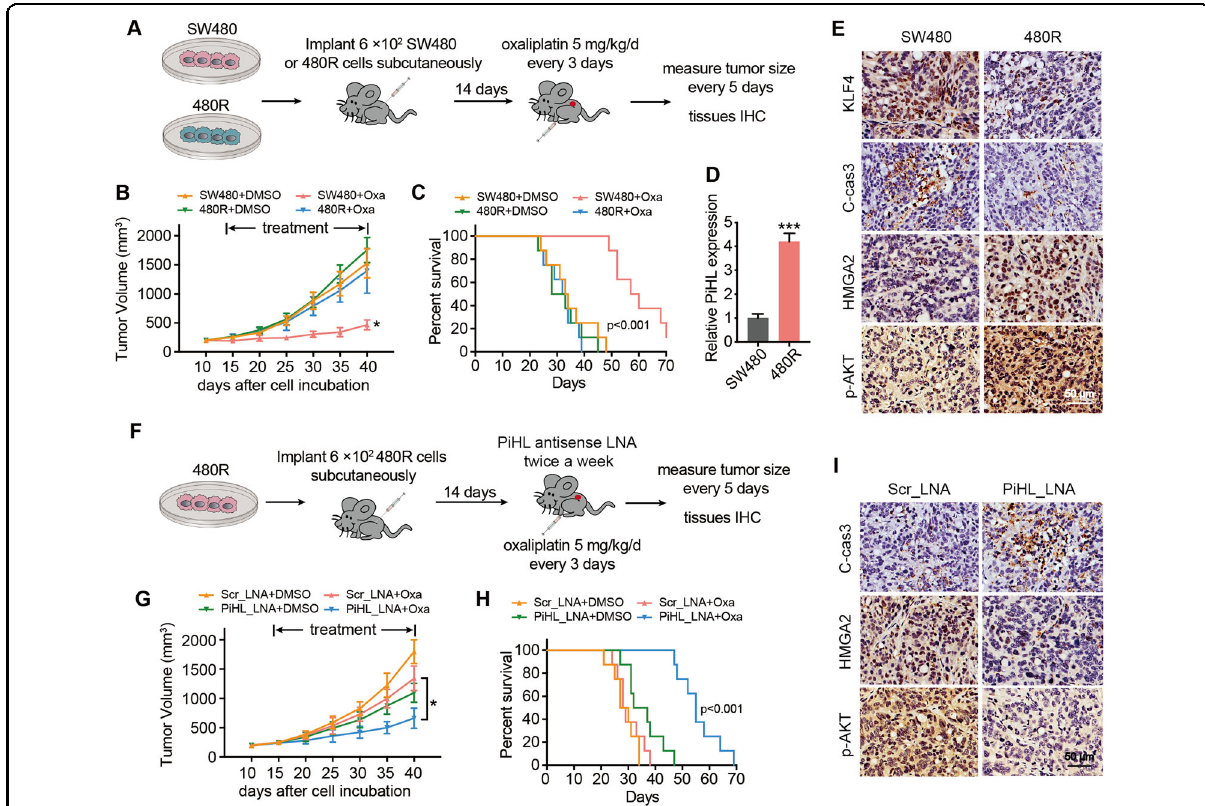
Fig. 6 Knockdown of PiHL restores oxaliplatin sensitivity in Oxa-resistant CRC xenografts. A Nude mice were subcutaneously xenografted with SW480 and 480R CRC cells (6 × 10 2 cells) and treated intraperitoneally with oxaliplatin (5 mg/kg/day per mouse) or DMSO (0.3%) every 5 days. B Relative tumor volumes are presented as mean ± SD, n = 8. C Kaplan – Meier survival curve of nude mice is shown. D PiHL levels in SW480 and 480R xenografts were analyzed by qRT-PCR. E IHC staining of KLF4, cleaved caspase-3, HMGA2, and p-Akt in consecutive tumor sections of mice subcutaneously xenografted with SW480 and 480R CRC cells. Scale bar = 50 μ m. F Nude mice were subcutaneously xenografted with 480R CRC cells (6 × 10 2 cells) transfected with PiHL_LNA or LNA_scramble and treated intraperitoneally with oxaliplatin (5 mg/kg/day per mouse) or DMSO (0.3%) every 5 days. G Relative tumor volumes are presented as mean ± SD, n = 8. H Kaplan – Meier survival curve of nude mice is shown. I IHC staining of cleaved caspase-3, HMGA2, and p-Akt in consecutive tumor sections of mice subcutaneously xenografted with 480R CRC cells. Scale bar = 50 μ m. * P < 0.05, *** P <